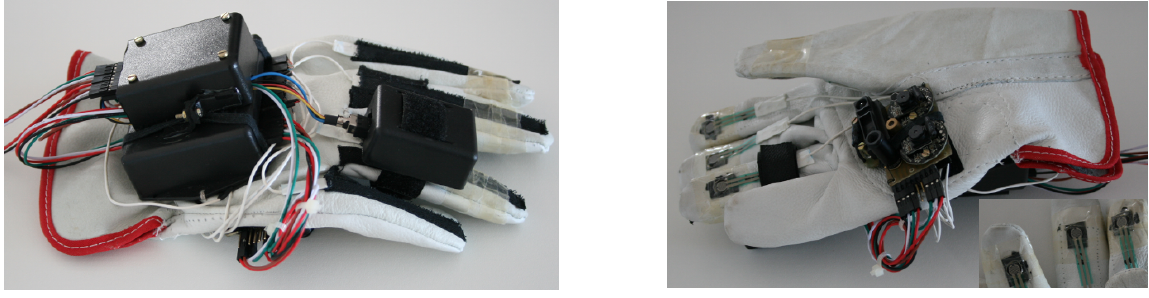
Figure 9. Top and bottom view of the glove. On the left are finger bending sensors, IMU and USB HUB. On the right there are the optical sensors and finger pressure